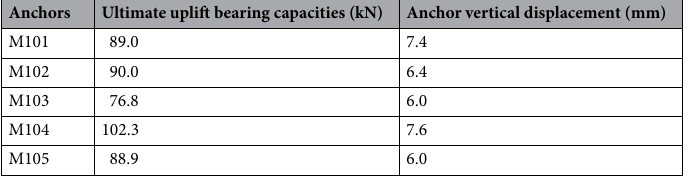
Table 3. Ultimate uplift bearing capacities and vertical displacement of group M1.